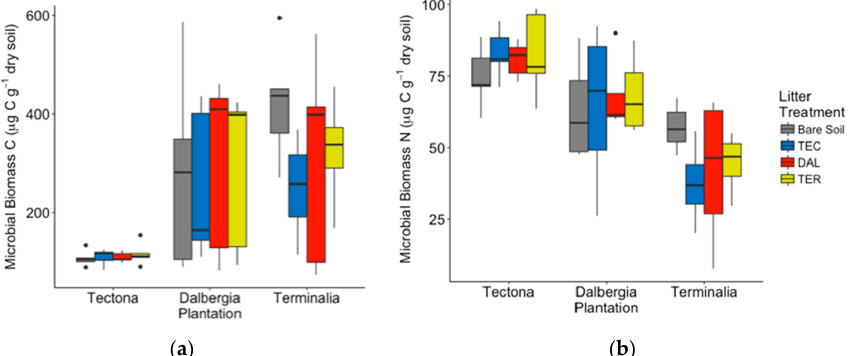
Figure 4. Litter mass loss after three months (April 2017) and six months (July 2017) in a litter decomposition experiment in monoculture plantations of Tectona grandis, Dalbergia retusa and Terminalia amazonia in Panama, Central America. Mass loss was measured for each litter type in all plantations, where TEC is Tectona grandis , DAL is Dalbergia retusa and TERM is Terminalia amazonia litter ( n = 5).